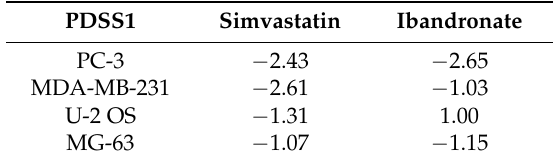
Table 9. Fold downregulation of prenyl (decaprenyl) diphosphate synthase subunit 1 PDSS1 .